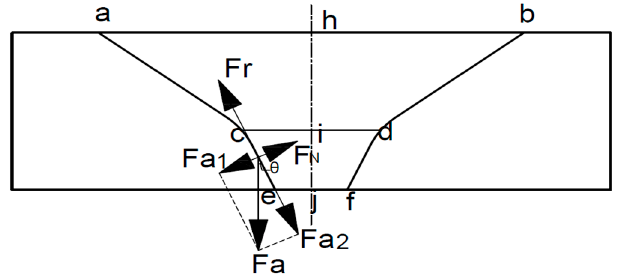
Figure 13. Schematic diagram of the FPW joint structure and force analysis.